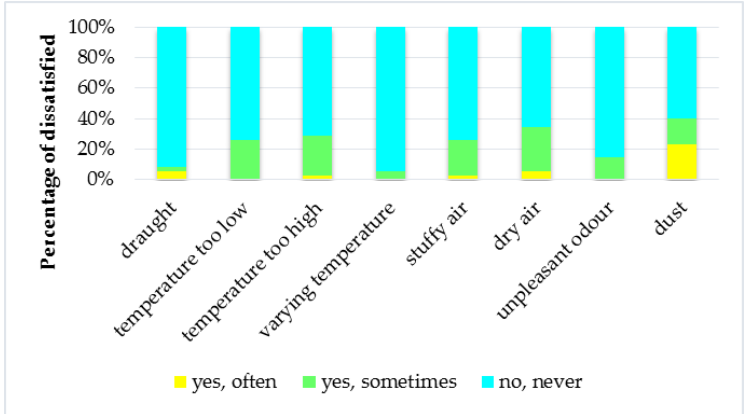
Figure 2. Problems with factors affecting the IEQ. Int. J. Environ. Res. Public Health 2017 , 14 , 1443